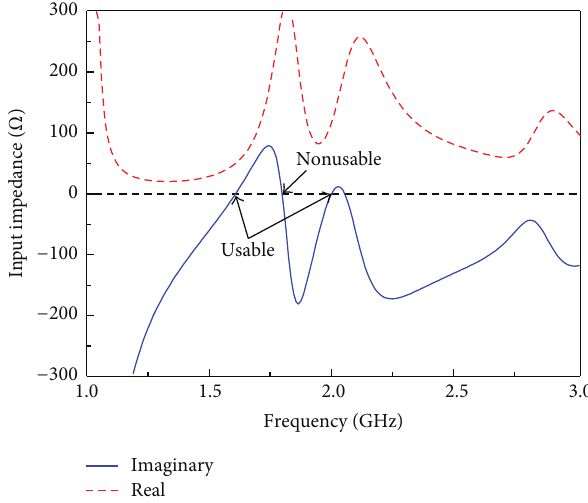
Figure 4: Simulated input impedance ( 𝑍 11 or 𝑍 22 ) of the ideal asymmetrical four-arm curl antenna ( 𝑛 1 = 𝑛 2 = 0.9 , 𝑛 3 = 𝑛 4 = 1 ).